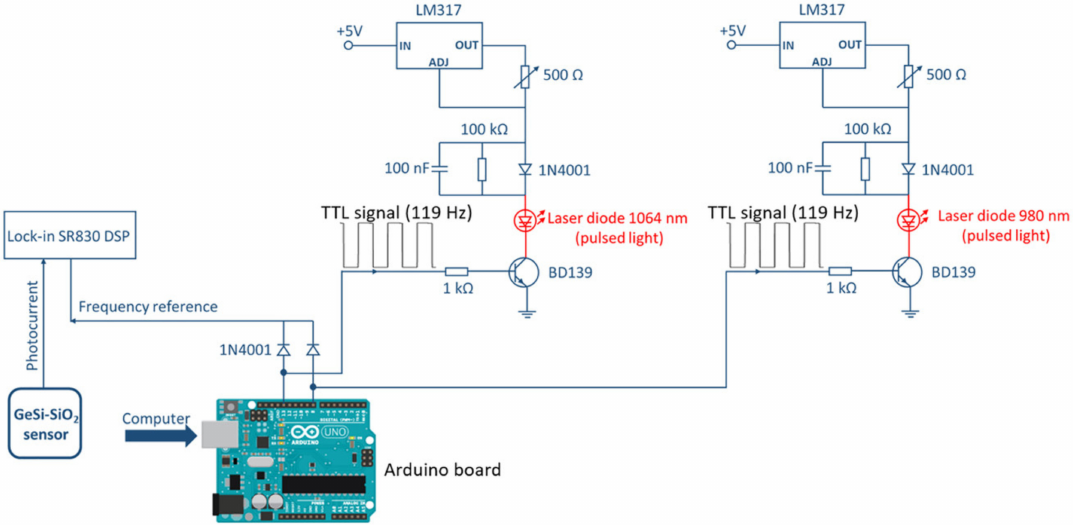
Figure 5. The electric circuit of the laser diode power